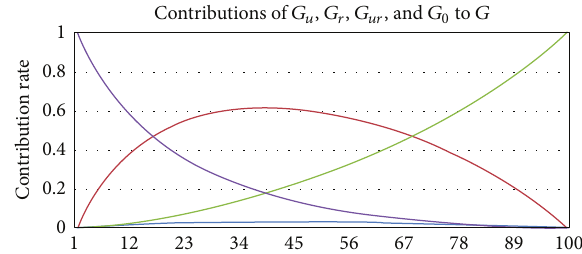
Figure 4: Contribution rate of 𝐺 𝑢 , 𝐺 𝑟 , 𝐺 𝑢𝑟 , and 𝐺 0 to the Gini coefficient of residents in